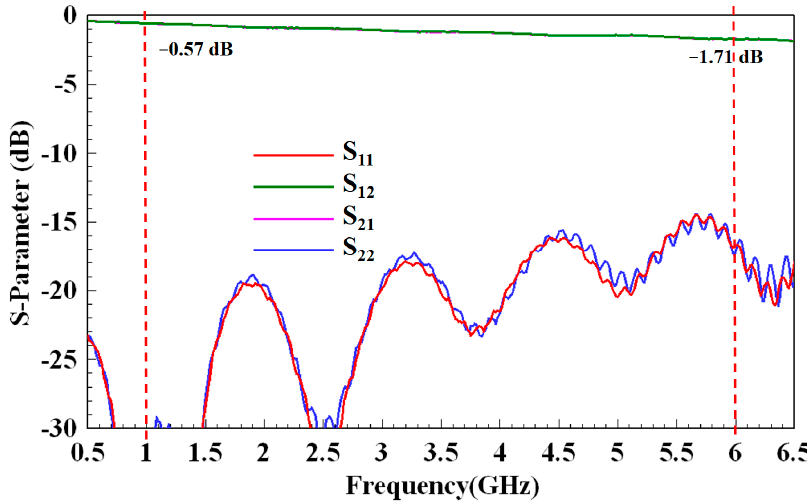
Figure 7. Measurement result of the calibration setup in Figure 5. S 11 and S 22 are the return losses of